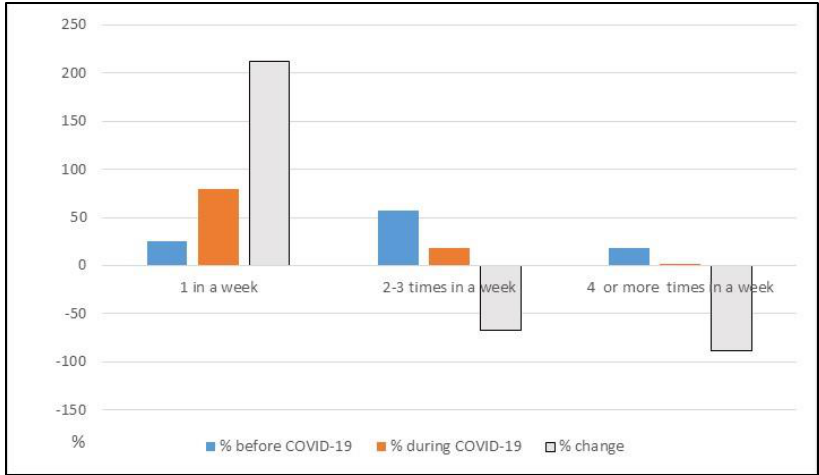
Figure 4. Changes in the weekly spending frequency before and during COVID-19. Source: The authors.